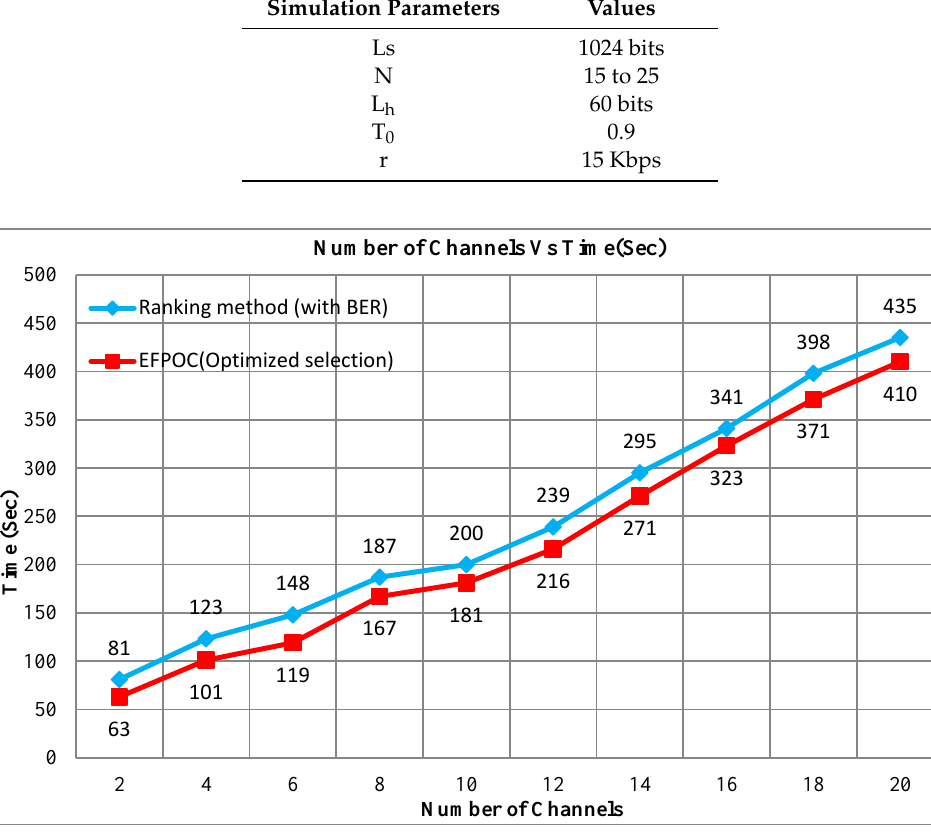
Figure 7. Number of Channels vs. Time (ms).